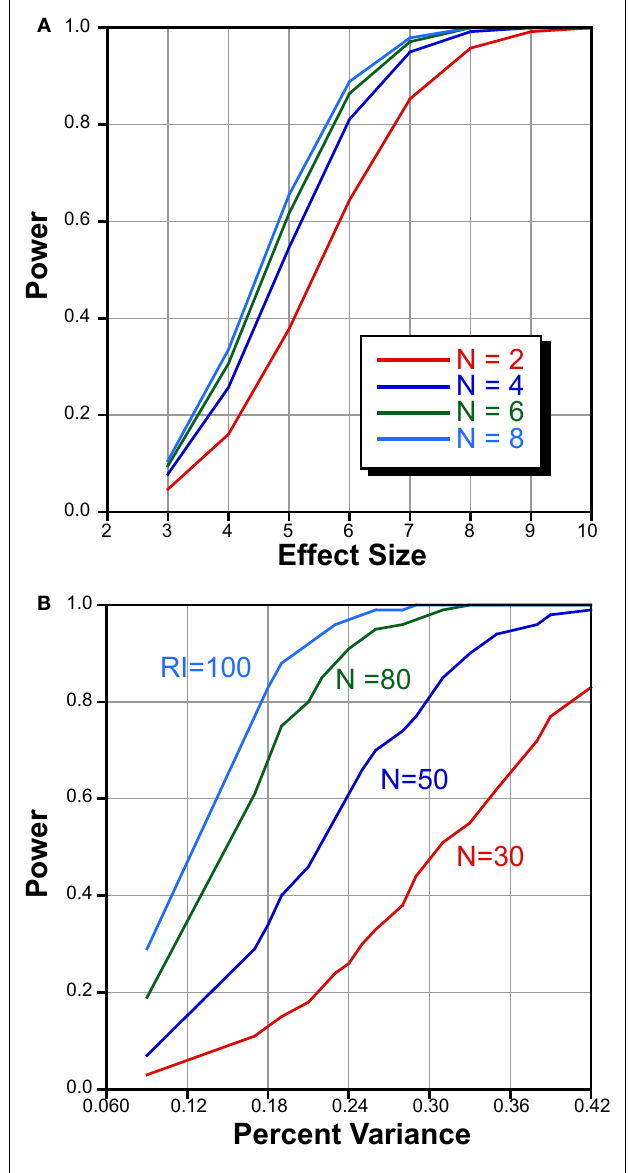
FIGURE 5 | Power analysis to determine optimal number of strains and mice/strain. (A) Power statistics for number of mice within strain as a function of effect size. Increasing the number of mice beyond 4 offers little benefit. (B) Power analysis of different numbers of RI strains as a function of percent variance. Increasing the number of RI strains increases the likelihood of detecting small effect